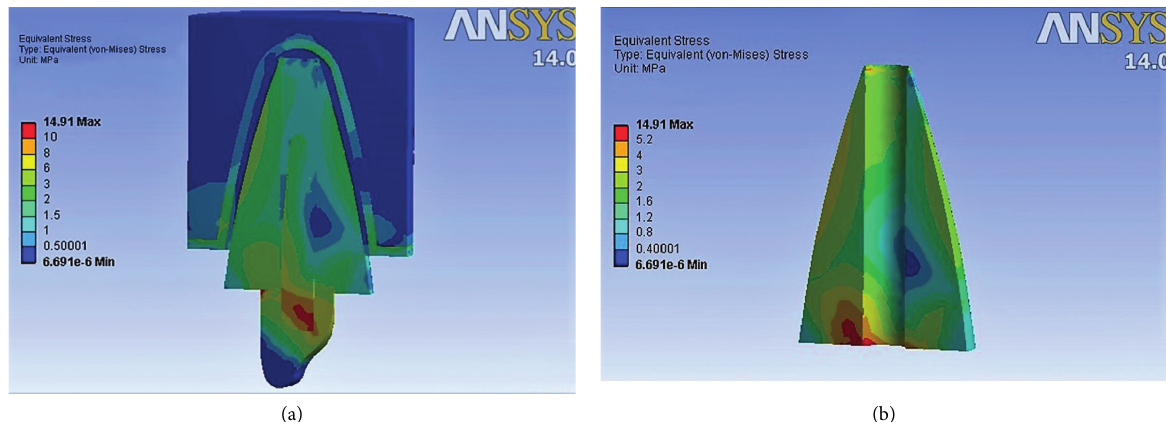
Figure 6: (a) Areas of stress concentration in Model 3 on oblique loading. (b) Areas of stress concentration in Model 3 in root cross section.